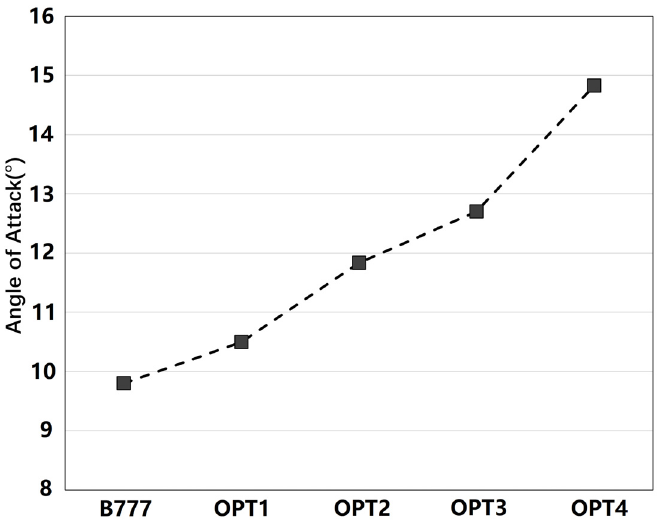
Figure 12. Landing angle of attack of each type of aircraft in the configuration family.